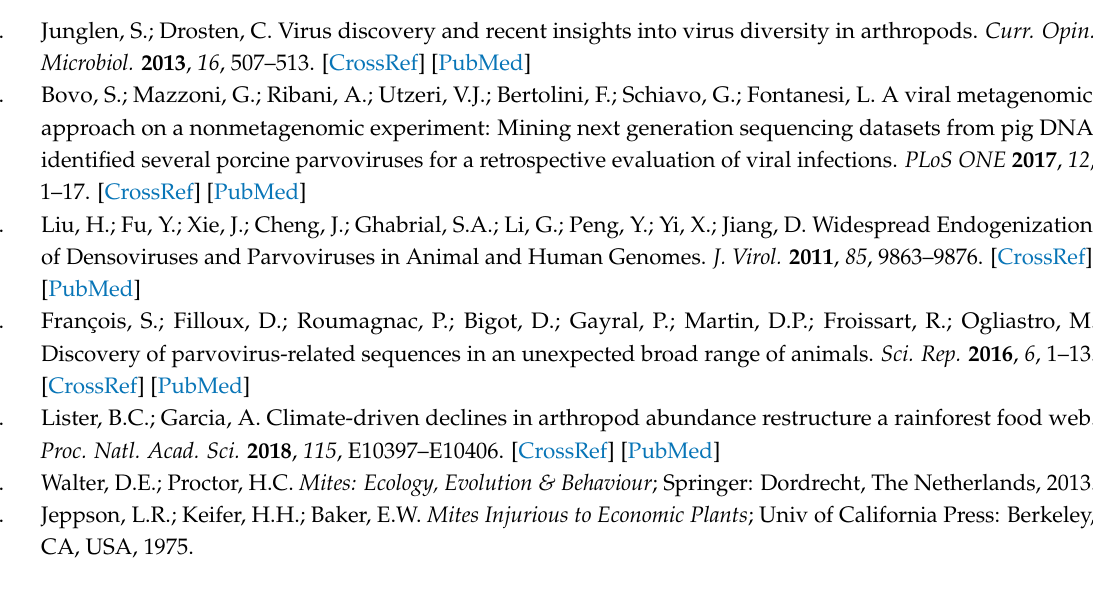
Table S1: Tetranychus species screened for the presence of TuaDV, Table S2: Sequences of TuaDV primers. Author Contributions: Conceived and designed the experiments S.F., A.B.D., P.R., R.F., M.O. Performed the experiments: S.F., D.M., L.R.R., S.L., D.F., I.S., C.D., E.F. Sampling: L.R.R., M.F., I.S. Analyzed the data: S.F.,